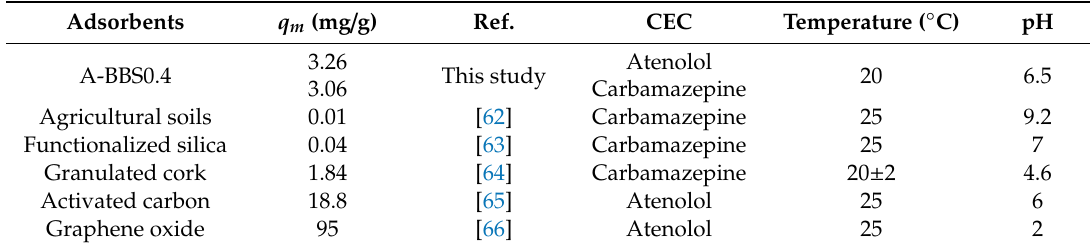
Table 6. Removal of organic pollutants from